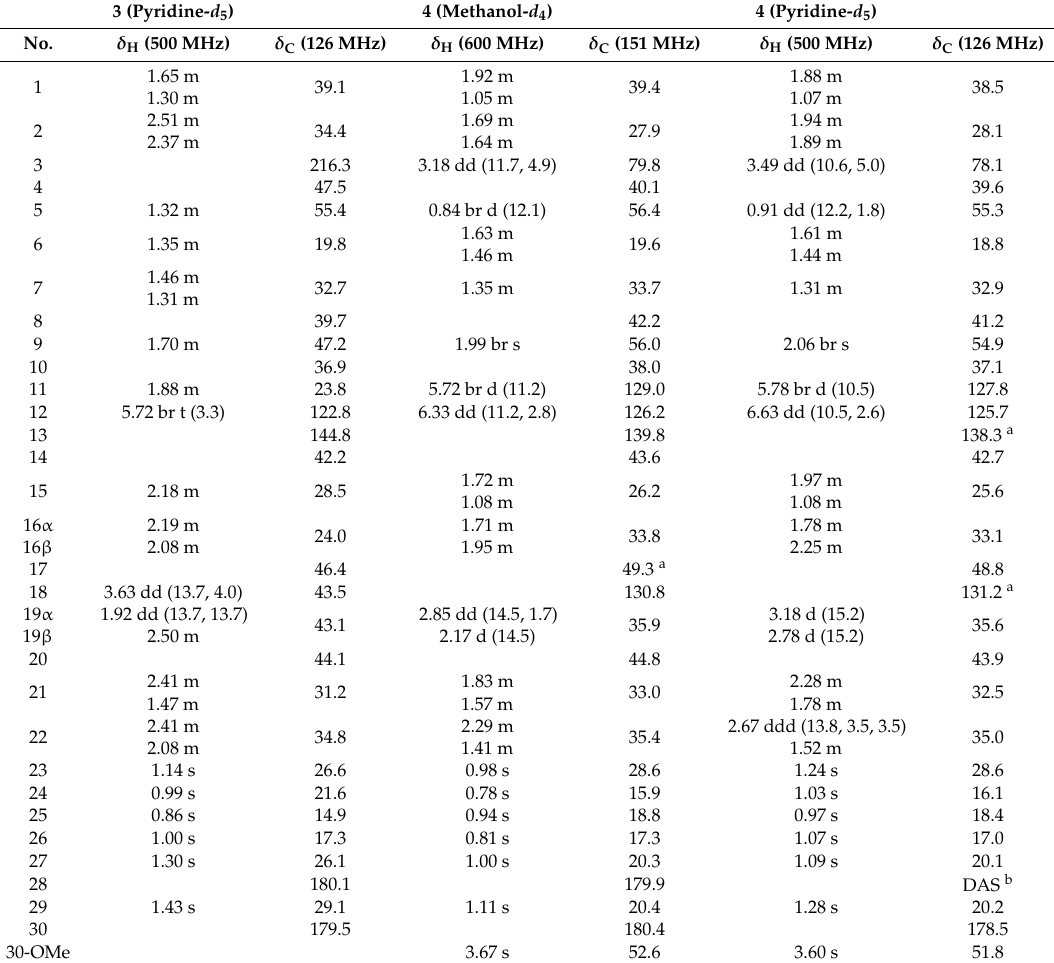
Table 2. 1 H and 13 C-NMR data of 3 and 4 ( δ in ppm, J in